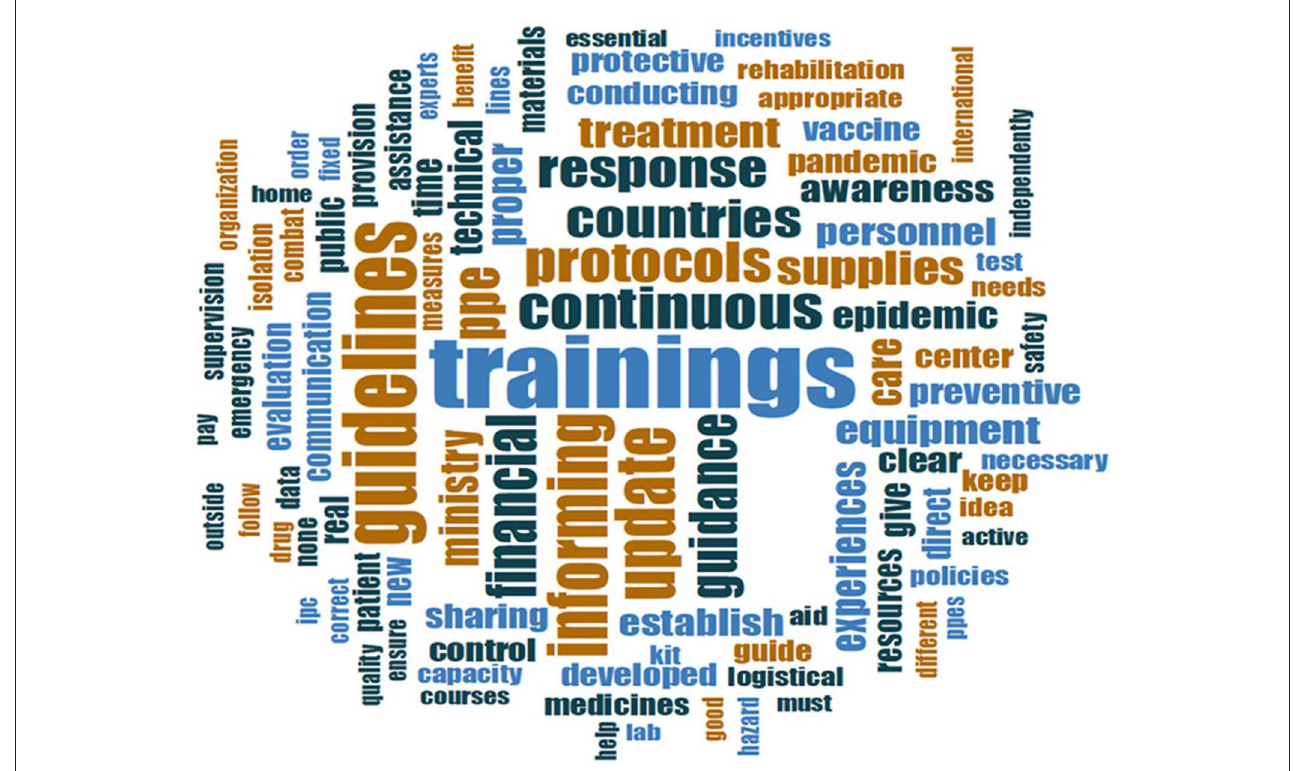
FIGURE4 Word cloud of qualitative responses on hospitals expectations from WHO in enabling recovery from